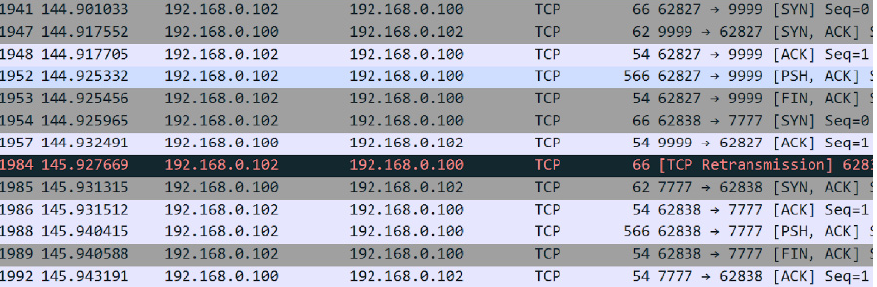
Figure 20. The regular node (192.168.0.100) receives the new block and the decision-making process.